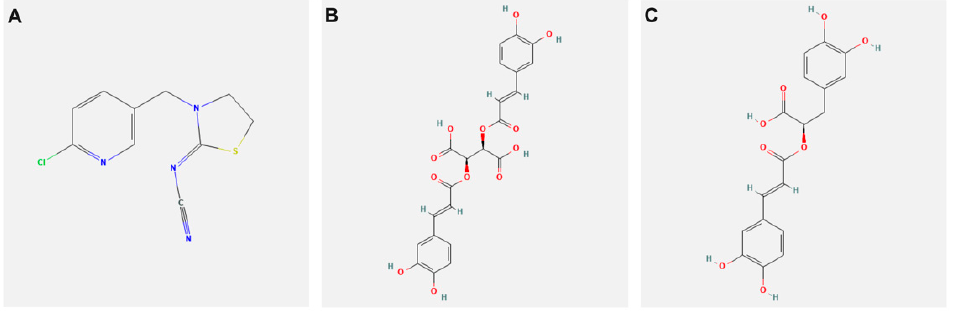
Figure 1. 2D chemical structure representation of ( A ) Thiacloprid, ( B ) Chicoric, and ( C ) Rosmarinic acid (PubChem source).